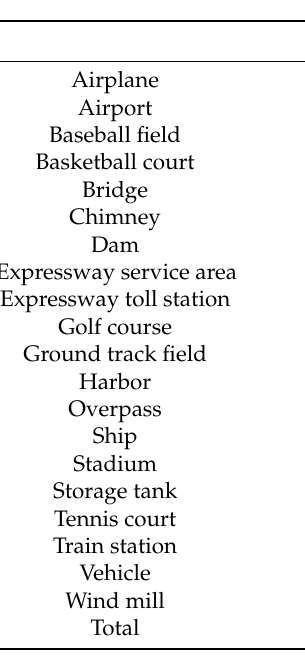
Table 2. Details of instances number in DIOR dataset [27].